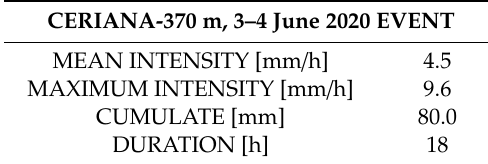
Table 7. Characteristics of the 3–4 June 2020 rainfall